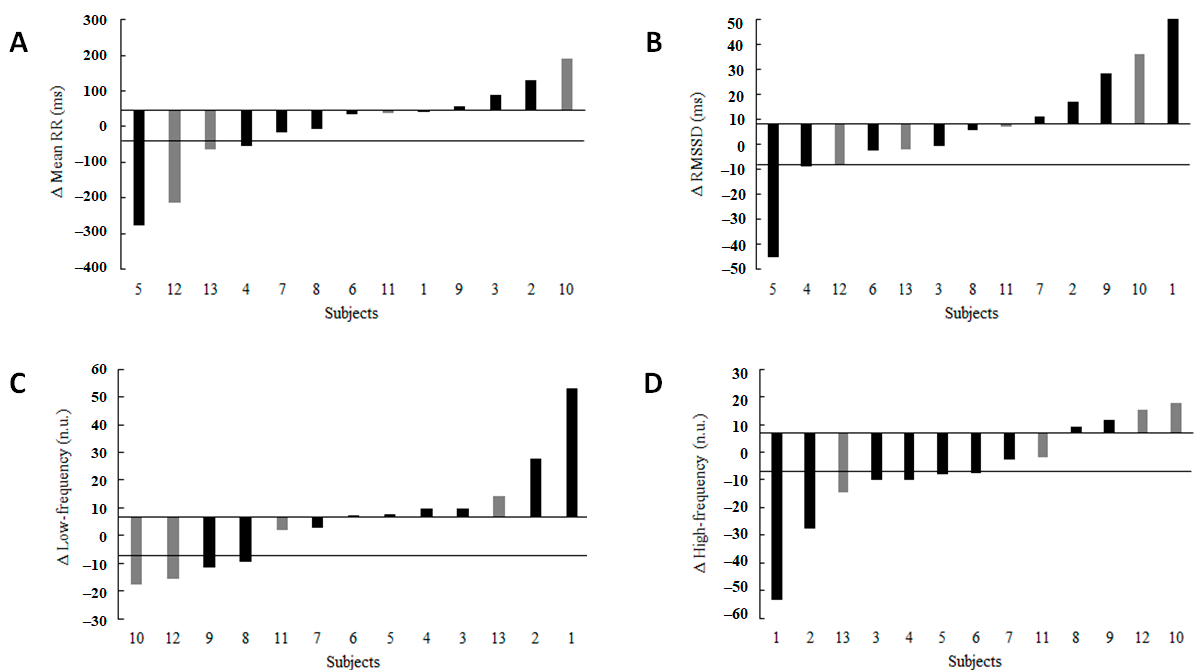
Figure 3. Individual responses of all participants for selected HRV parameters. Black bars belong to the HICT, while gray bars belong to CON. The upper and lower thresholds are depicted by continuous lines on the Y-axis of each figure. Individuals located between those lines are considered non-responders on that specific HRV parameter. ( A ) shows that three individuals in the HICT group and one individual in the control group responded to the intervention. ( B ) shows that only one individual in the HICT group responded to the intervention. ( C ) shows that two individuals in the HICT group and two individuals in the control group responded to the intervention. ( D ) shows that five individuals in the HICT group and one individual in the control group responded to the